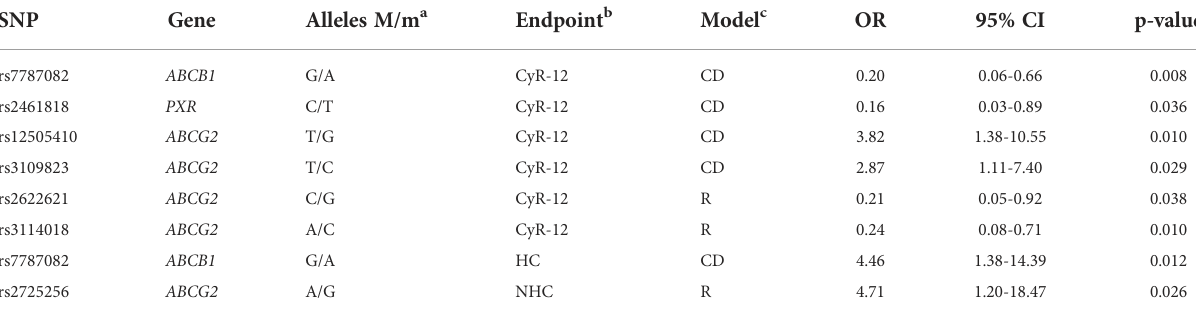
TABLE 2 Associations between selected SNPs and cytogenetic response after 12 months of treatment as well as incidence of hematological and non-hematological